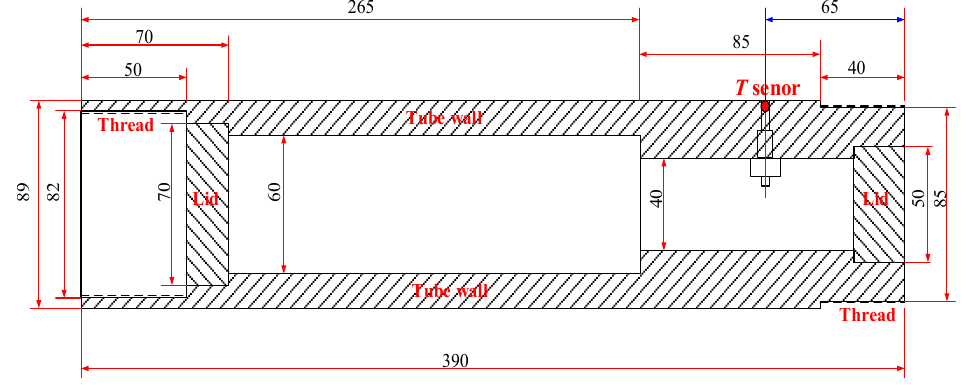
Figure 10. Thermometric tube size.